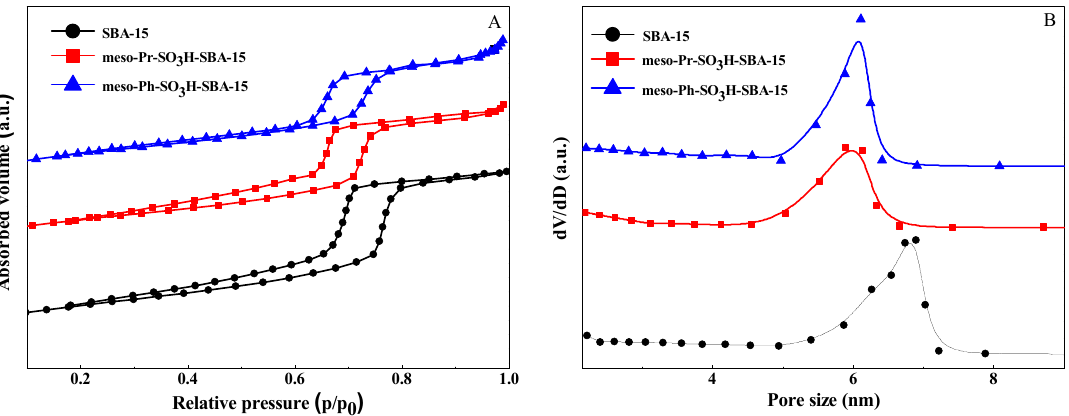
Figure 1. Nitrogen adsorption–desorption isotherms ( A ) and pore-size distributions ( B ) of SBA-15, mesoporous propyl sulfonic acid-functionalized SBA-15 (meso-Pr-SO 3 H-SBA-15) and mesoporous phenyl sulfonic acid-functionalized SBA-15 (meso-Ph-SO 3 H-SBA-15)